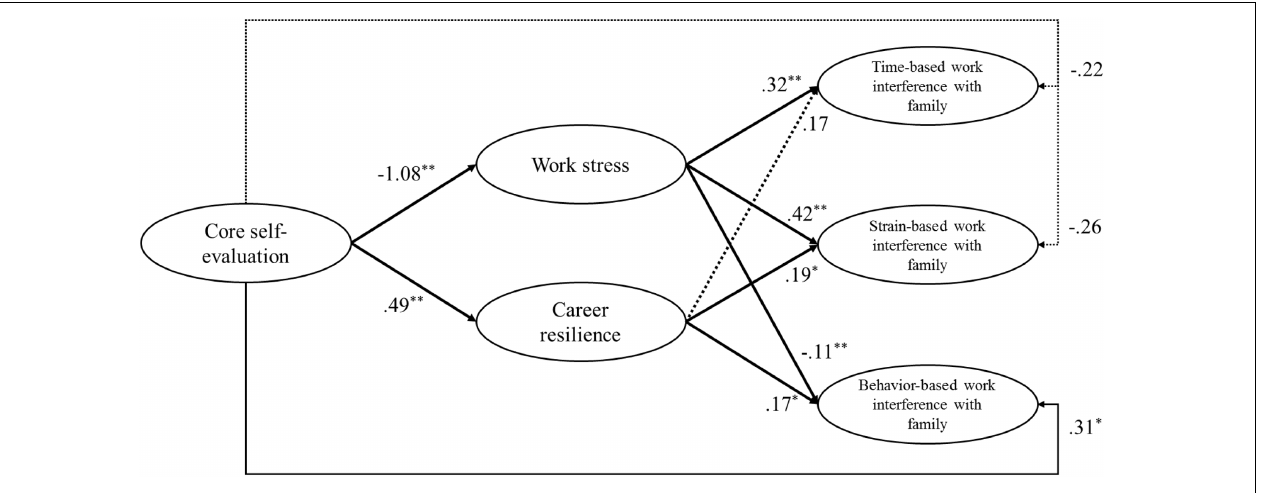
p < 0.05) and WIFS ( β = 0.19, p < 0.05) were significantly positive, while the direction path to WIFT was not significant ( β = 0.17, p > 0.05). Thus, Hypothesis 7b and Hypothesis 7c were supported, and Hypothesis 7a was not